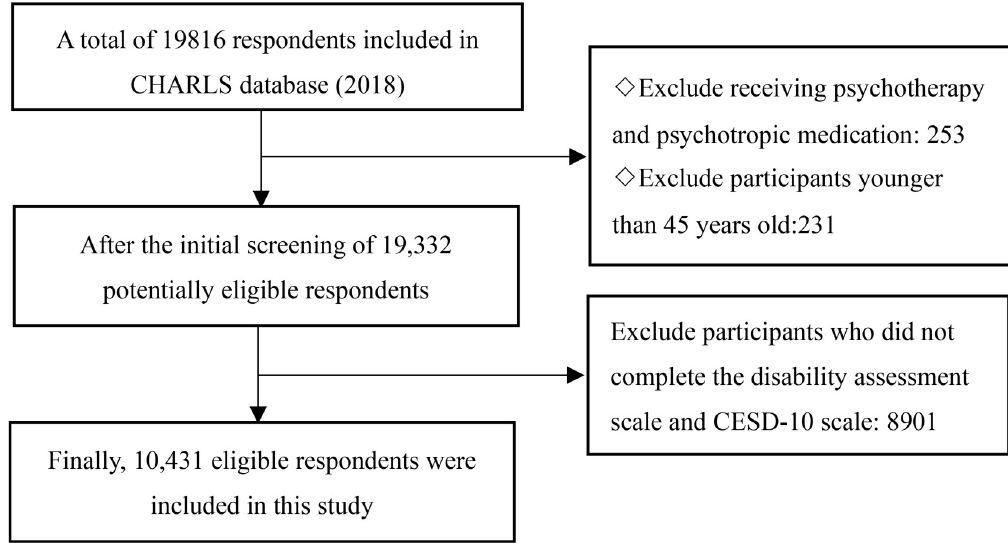
Fig 1. Flowchart of subject recruitment and